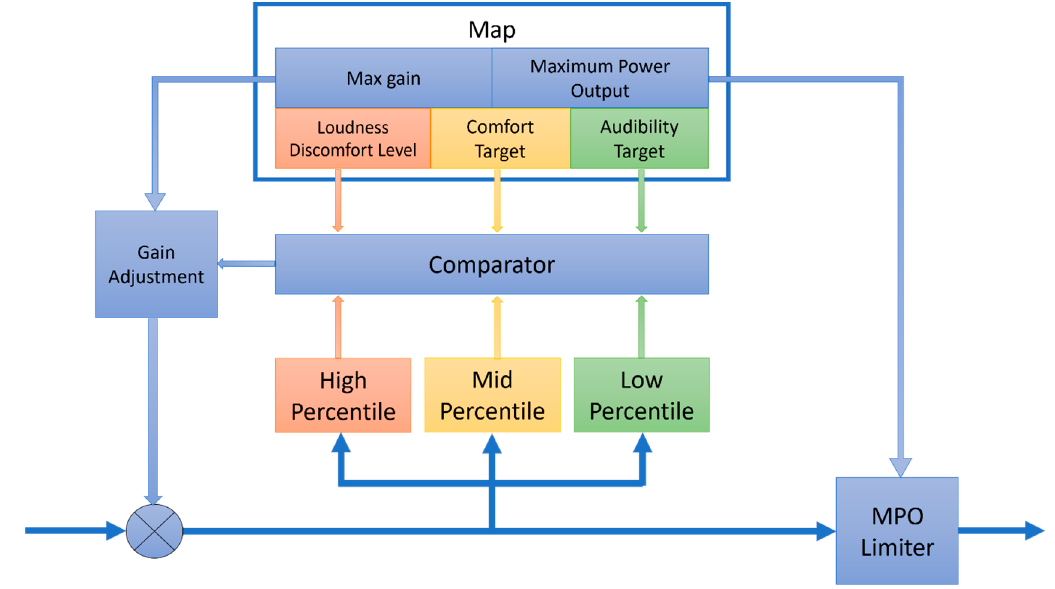
Figure 3. ADRO gain computation module.